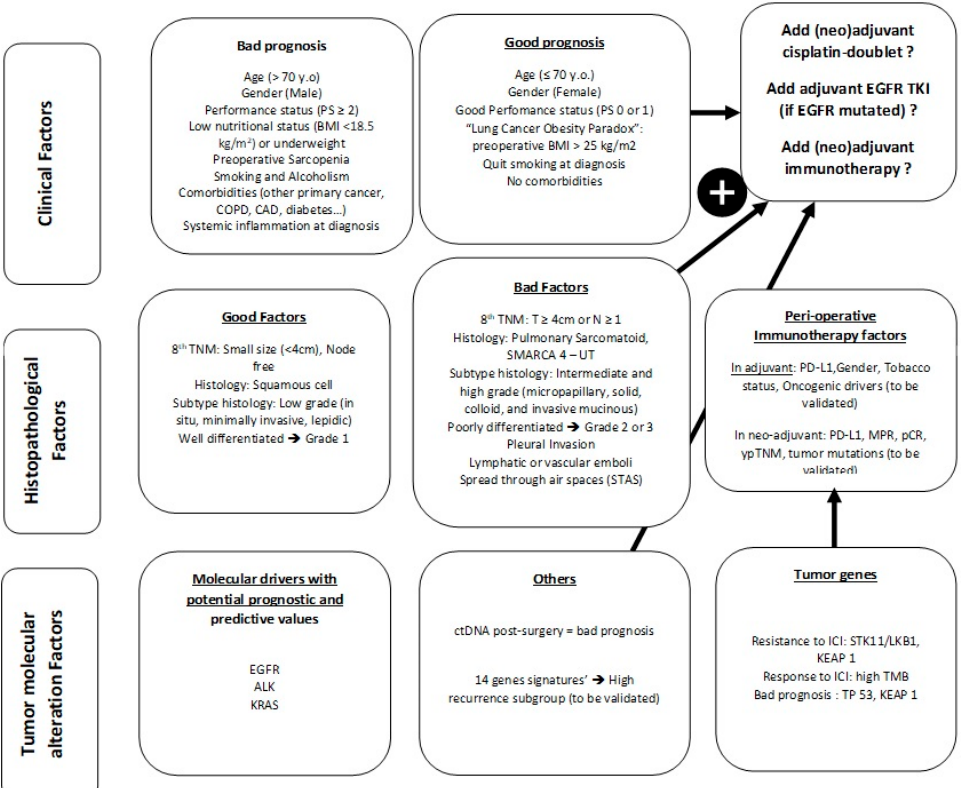
Figure 1. Summary of existing prognostic factors in localized NSCLC.